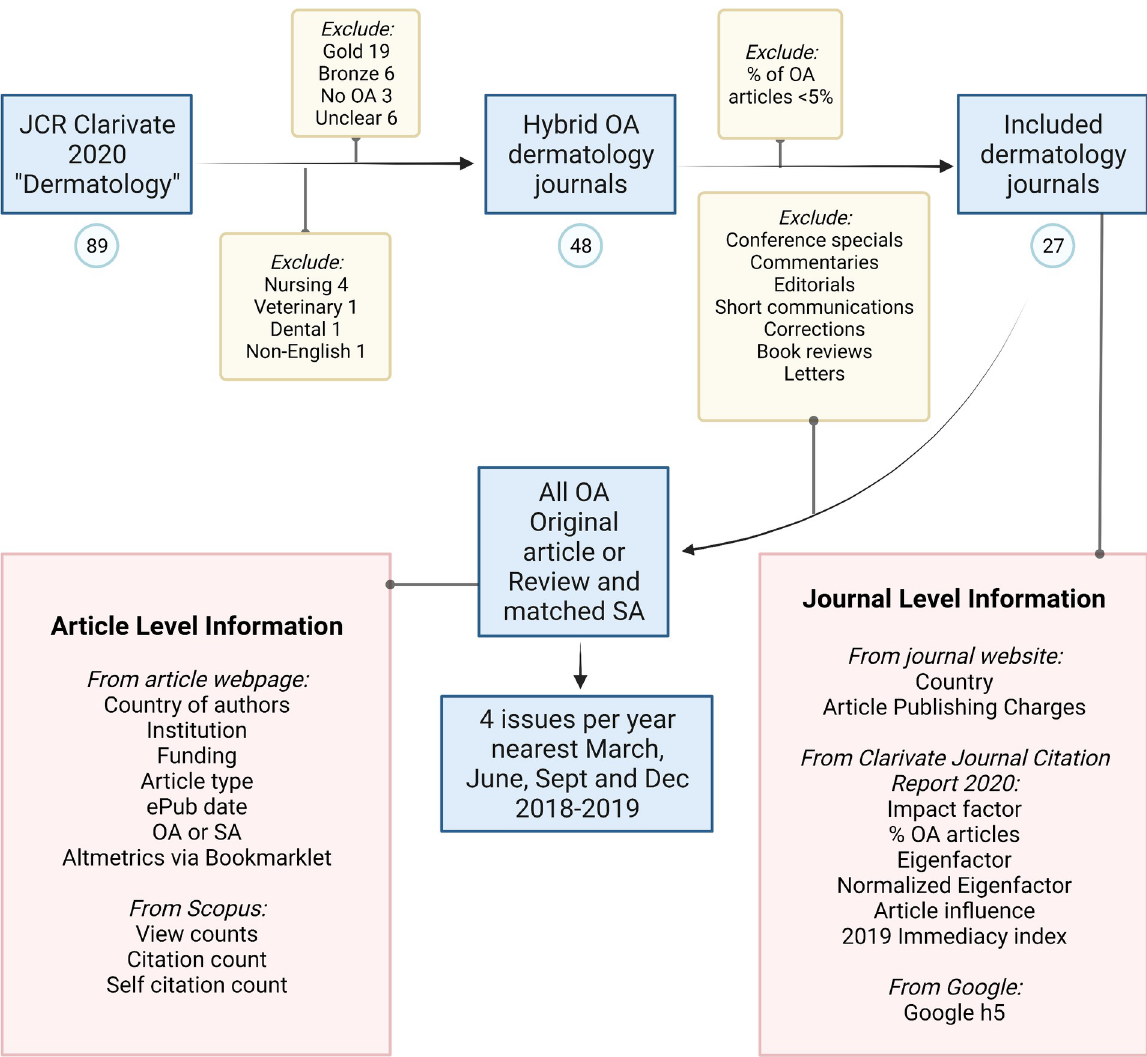
Fig 1. Methodology, including exclusion criteria and extracted bibliometric information, at journal and article level. OA indicates open access; SA, subscription-based access. Created with BioRender.com.